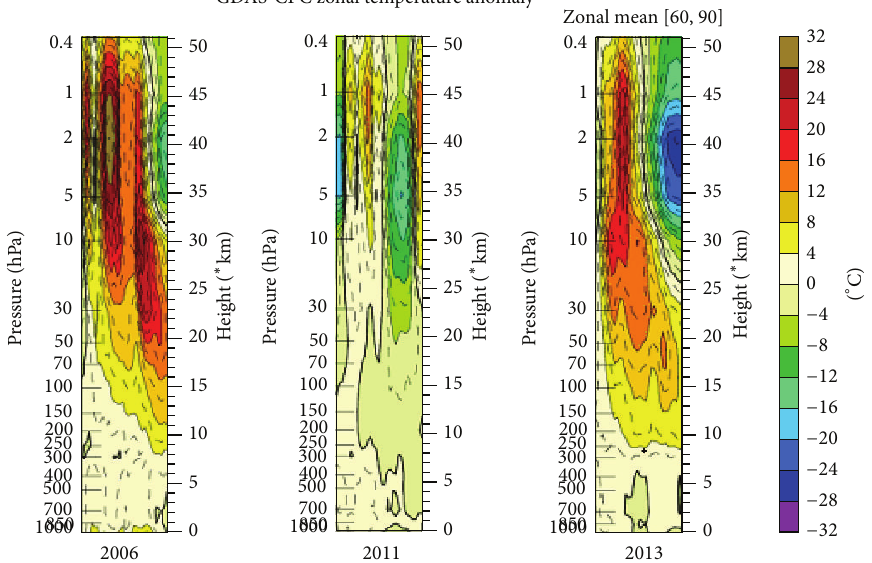
Figure 4: NCEP GDAS-CPC zonal mean time series of temperature for January of 2006, 2011, and 2013.